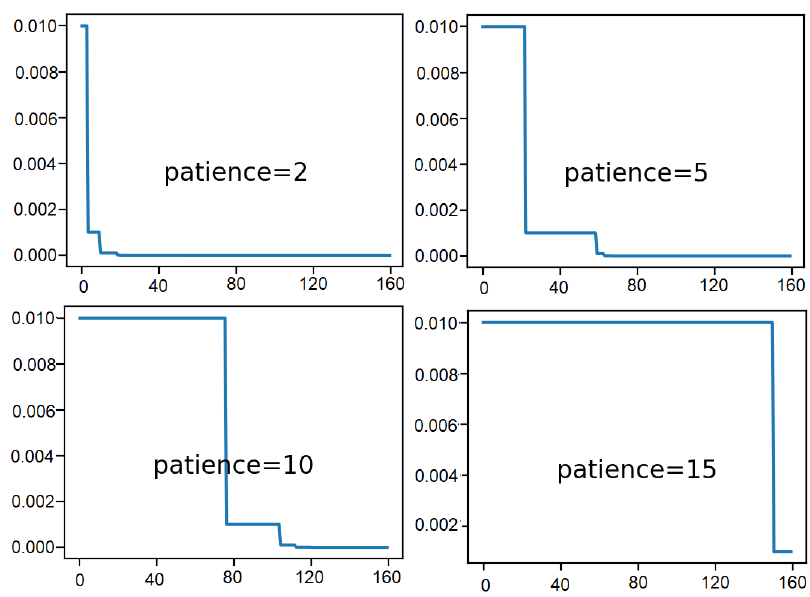
Figure 13. Result analysis of various patience values: learning rate over epochs.